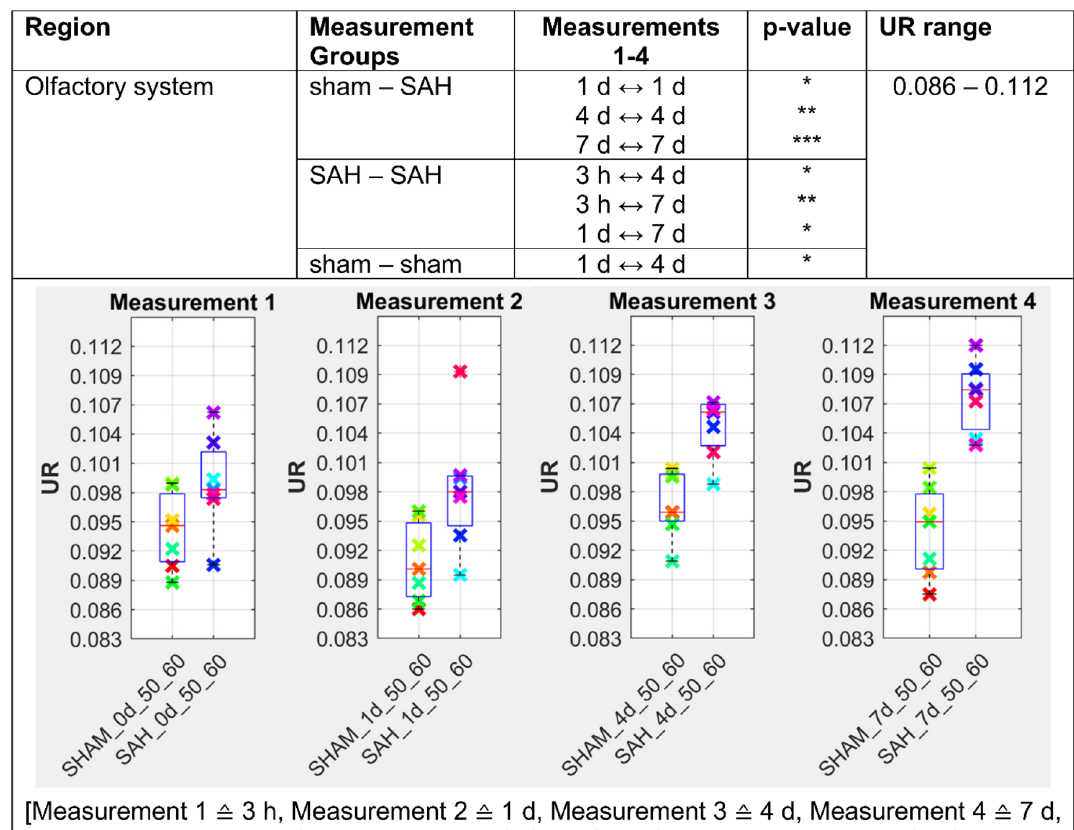
Figure 6. [ 18 F]FDG uptake ratio is significantly elevated in olfactory system on day 1 following SAH compared to sham operated controls. This more-uptake gets even more significant on day 4 (p ≤ 0.01) and on day 7 (p ≤ 0.001) following SAH/sham operation. p ≤ 0.05 *; p ≤ 0.01 **; p ≤ 0.001